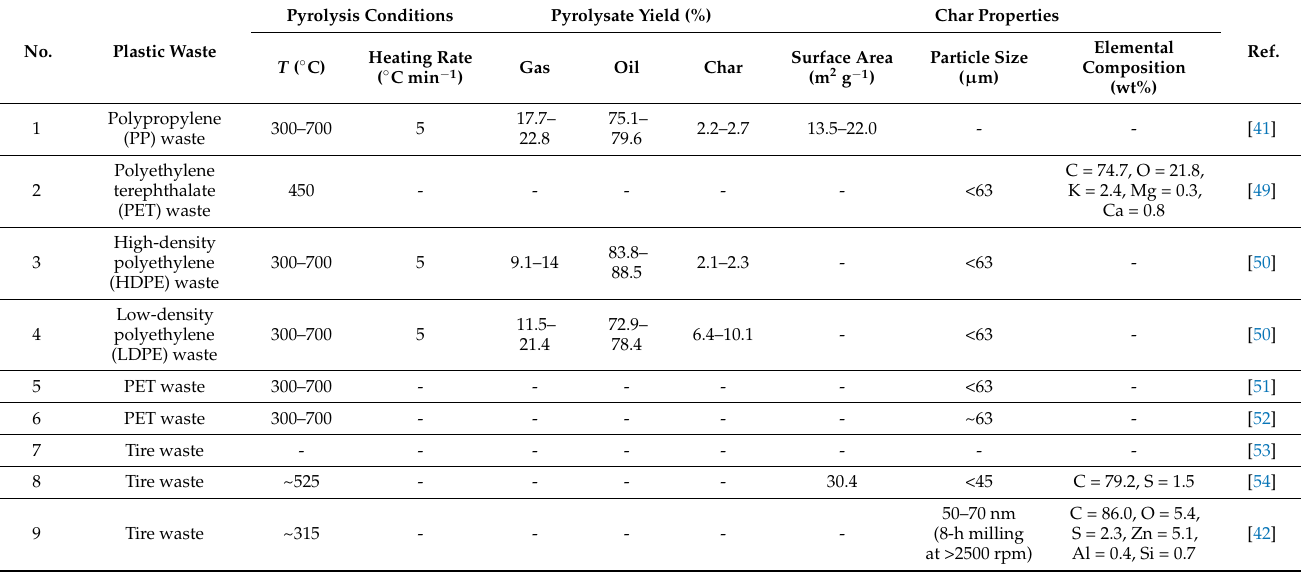
Table 1. Production of char from different plastic waste feedstocks: pyrolysis conditions, product yields, and char